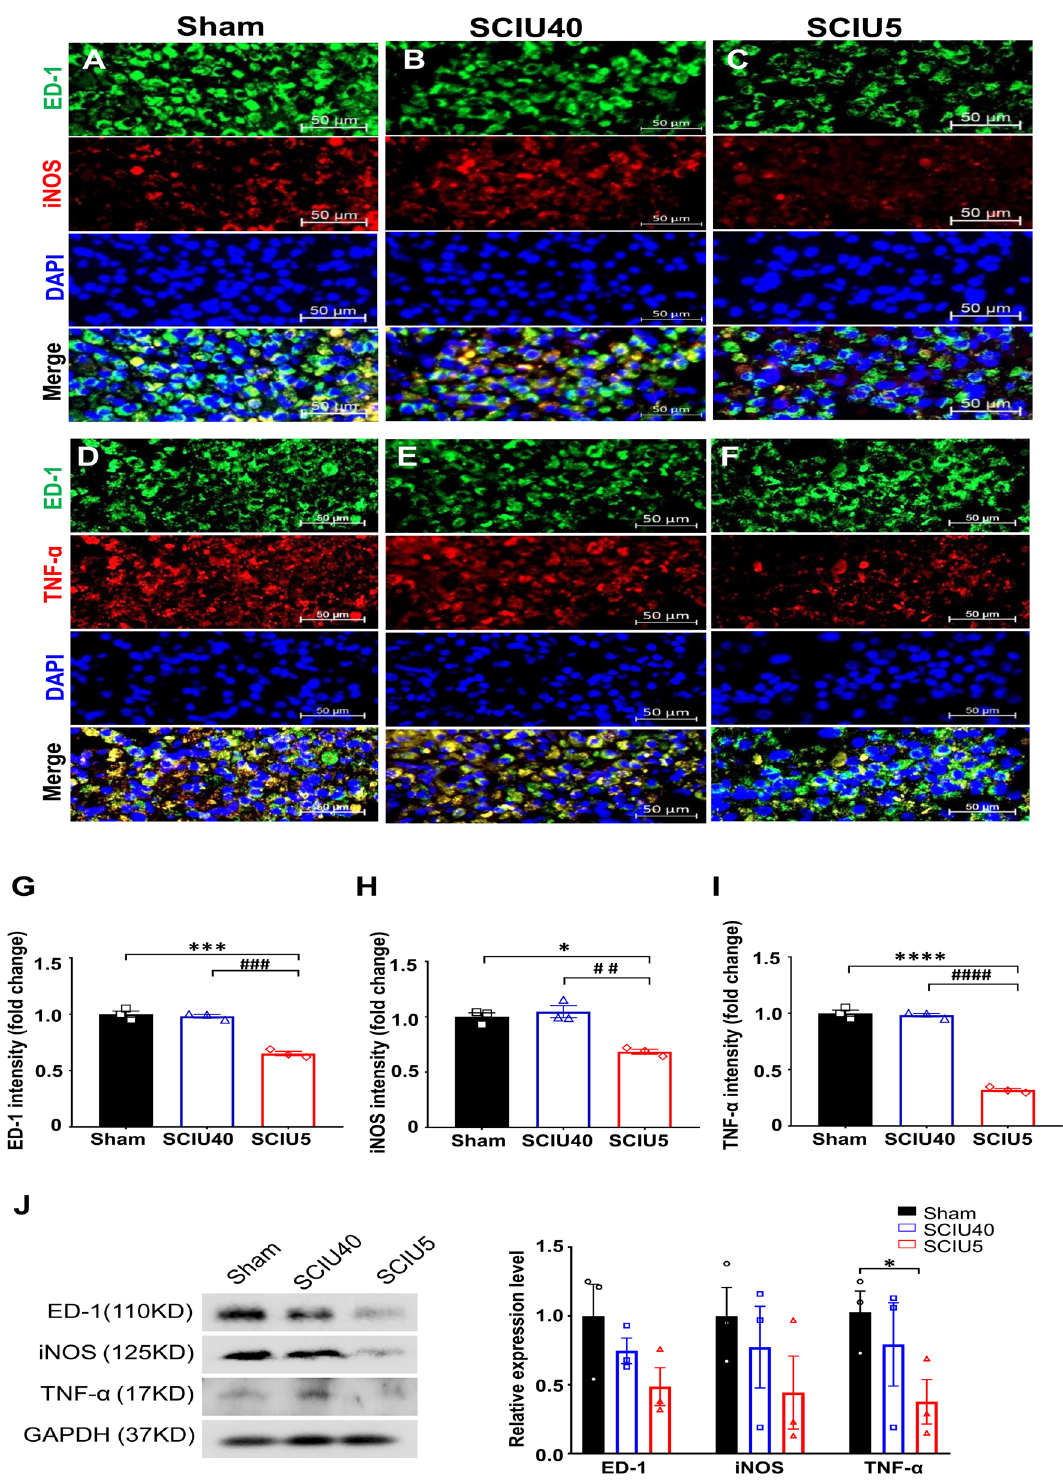
Figure 3. Ultrasound (US) stimulation reduces ED-1, iNOS, and TNF-α expression in the acute spinal cord injury (SCI) phase. ( A – C ) ED-1 (macrophage/microglia, green) and iNOS (inducible nitric oxide synthase, red) were evaluated in the sham ( A ), SCIU40 ( B ), and SCIU5 ( c ) experimental groups at 7 days post-SCI (five sections per rat, n = 3). ( D – F ) Cross-sections were counterstained with anti- TNF-α (red) and ED-1 (green) antibodies (five sections per rat, n = 3). ( G – I ) Quantification of fluorescence intensity of ED-1, iNOS, and TNF-α. Two-way ANOVA with Turkey’s test for multiple comparisons was used for analyses. *P < 0.05, ****P < 0.0001 compared with the sham control, # P < 0.05, ### P < 0.001, #### P < 0.0001 compared with the SCIU5-treated group. ( J ) Representative western blotting results for ED-1, iNOS, TNF-α, and GAPDH at 7 days post-SCI (Lane 1, sham; lane 2, SCIU40; lane 3, SCIU5;). Relative expression levels of ED-1, iNOS, and TNF-α were calculated after normalization to the level of GAPDH. Full-length blots are presented in Supplementary Fig. 8. Data are presented as means ± SEM. Two-tailed Student’s t -tests were used for comparison. *P < 0.05 compared with the sham